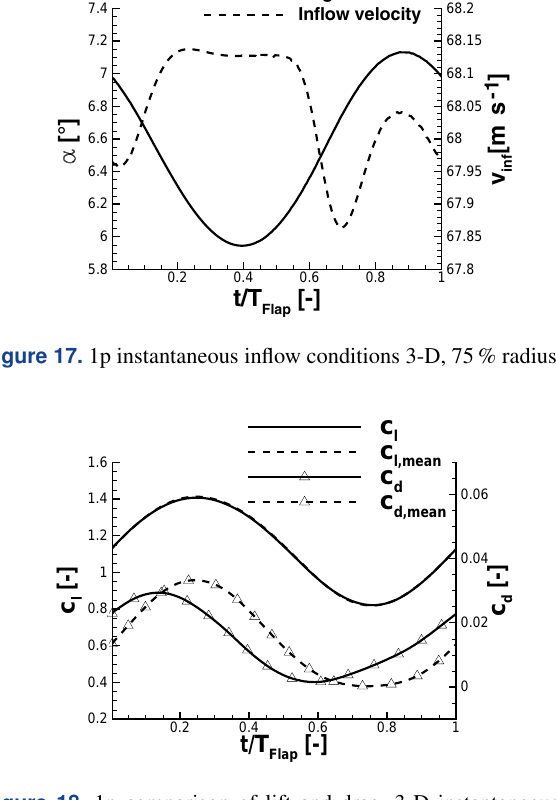
Figure 18. 1p comparison of lift and drag, 3-D instantaneous/3- D mean, 75%